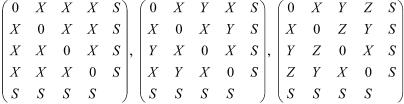
The Jukes–Cantor Matrix, Kimura-2 Matrix, and Kimura-3 MatrixThese three matrices correspond to JC69, K80, and K81 in the Felsenstein hierarchy [11] of probabilistic models for DNA sequence evolution.